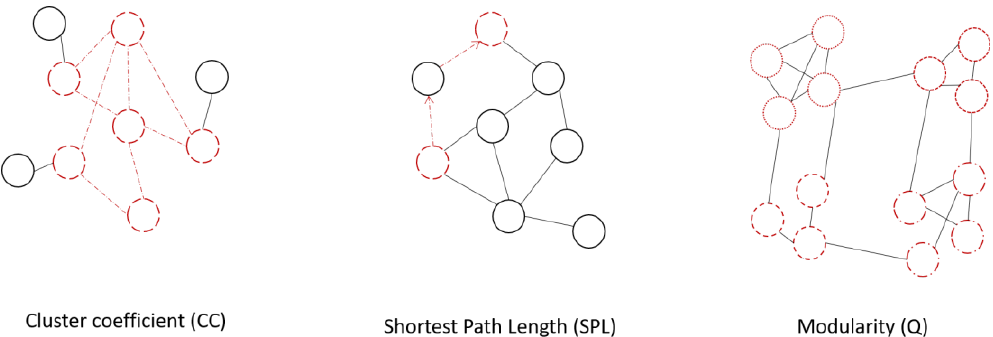
Figure 1. Visualization of the network measures used in the current study. The cluster coefficient measures the extent to which the nodes are interconnected. The shortest path length is the minimum number of edges between two nodes. The average shortest path length (ASPL) was calculated and used as a measure. Modularity measures the tendency to form subgroups within the network.